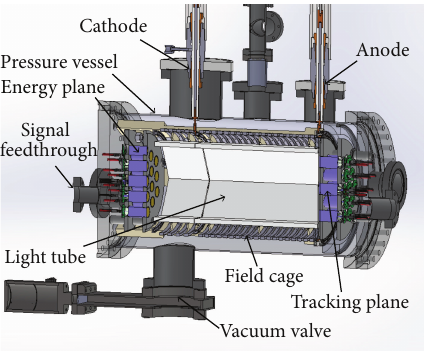
Figure 20: Cross section drawing of the NEXT-DEMO detector with all major parts labelled.